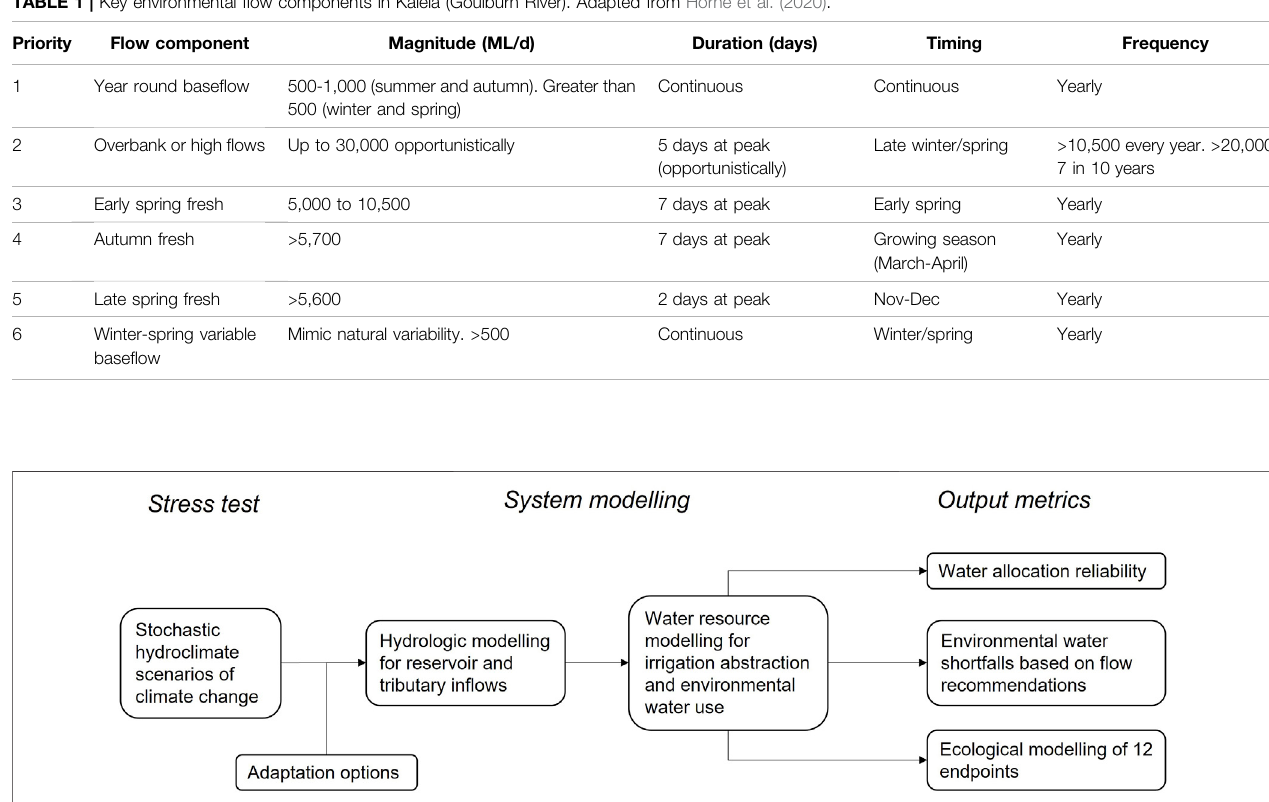
FIGURE 2 | Modelling and assessment framework used in this